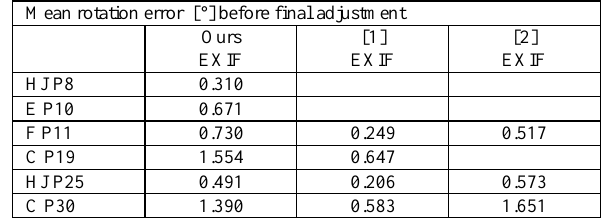
Table 2. Comparison of mean rotation errors before final bundle adjustment: [1] Reich & Heipke, 2016, GO-SDP-ls , [2] Jiang et al., 2013.